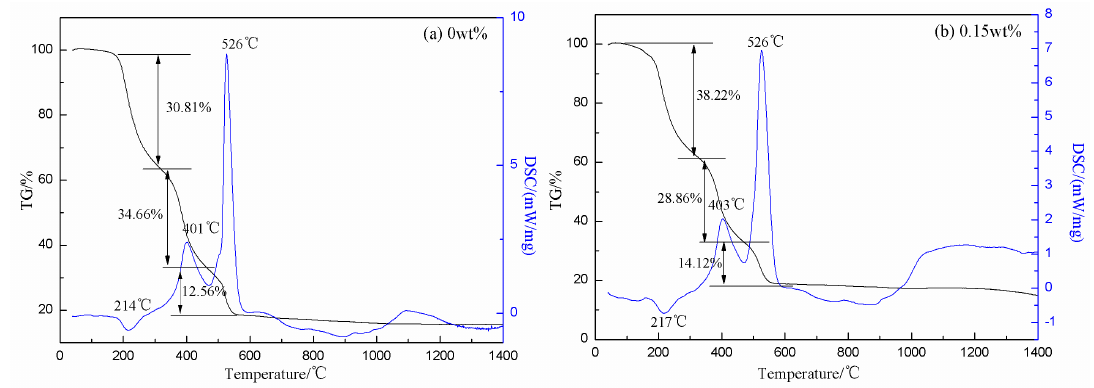
Figure 2. Thermogravimetry (TG) and differential scanning calorimetry (DSC) curves of the dry gel with different amounts of Cr 2 O 3 doping ( a ) 0 wt% Cr 2 O 3 ; ( b ) 0.15 wt% Cr 2 O